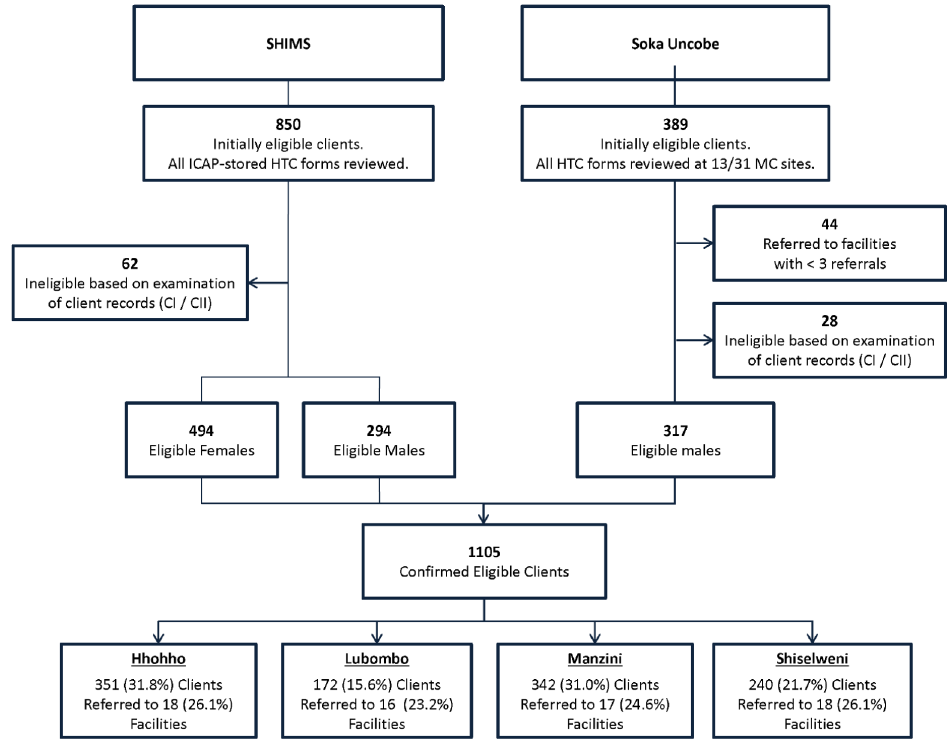
Fig 1. Distribution of newly HIV diagnosed SHIMS and SOKA clients referred to health facilities in the four regions of Swaziland.